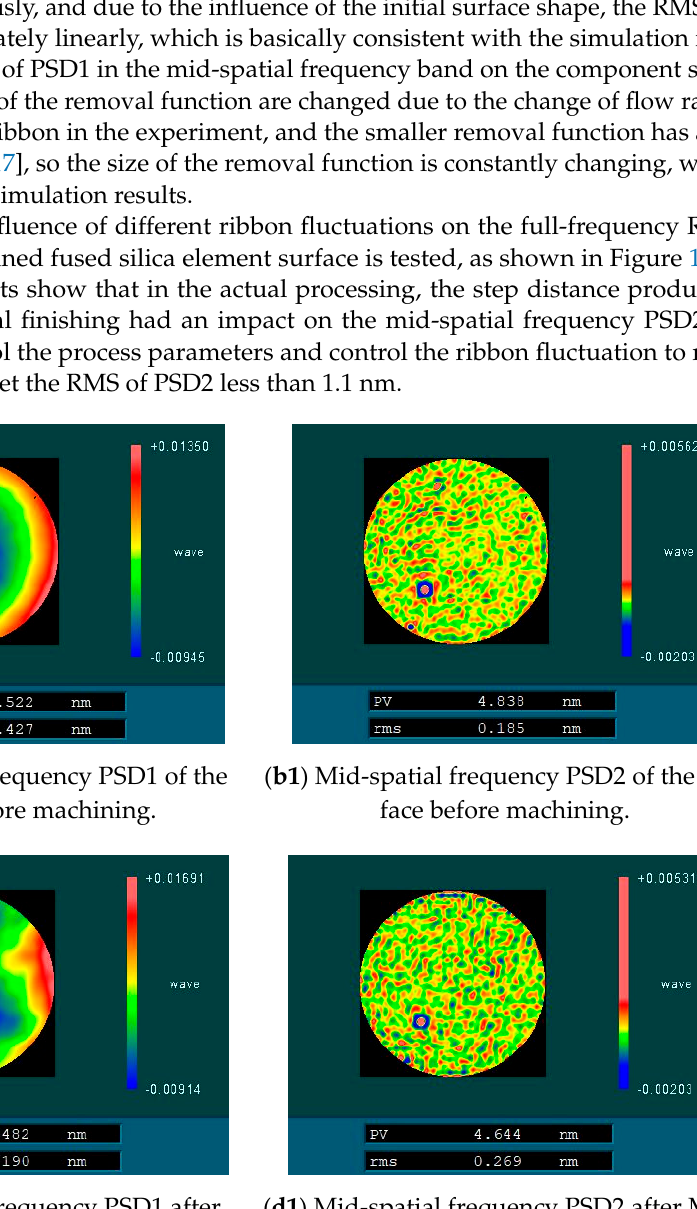
Table 1. Experimental